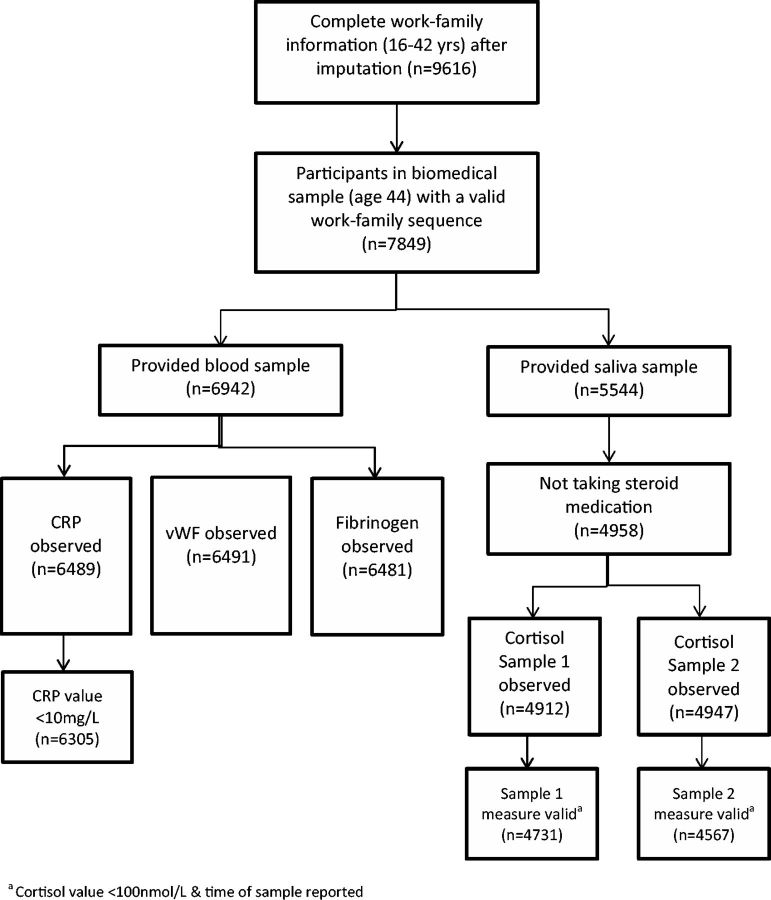
Sample selection process.